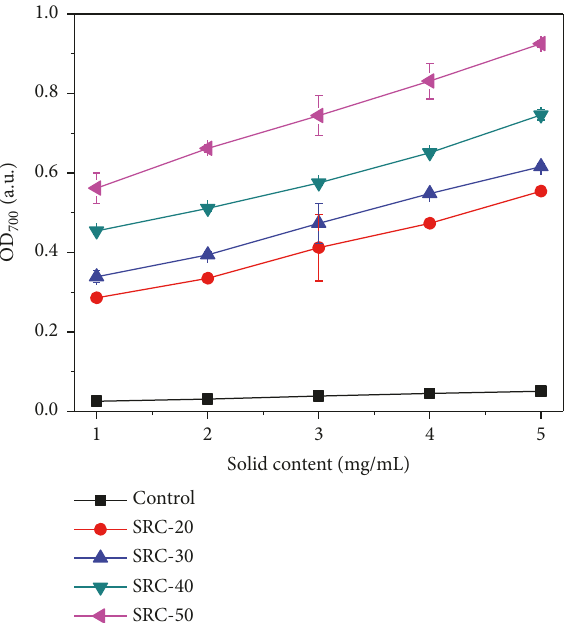
Figure 7: The relationship between the content of the SRCs and the reduction capacity.